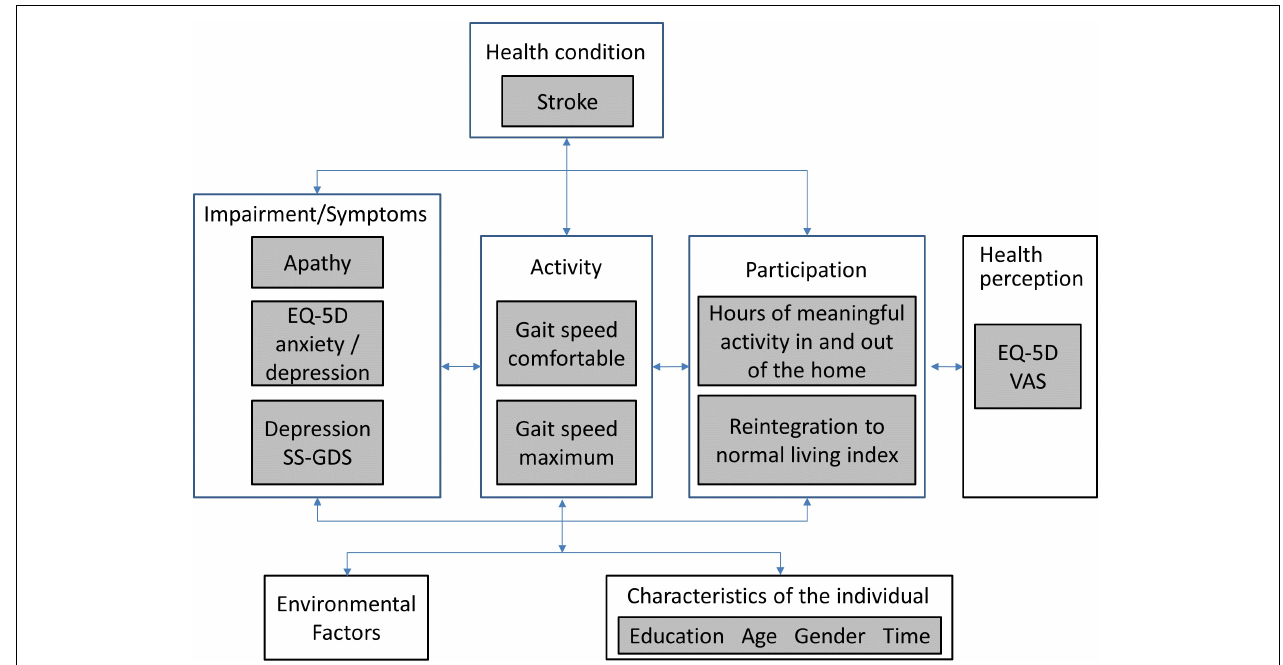
FIGURE 1 | WHO international classification of functioning, disability and health (ICF) for the measurement